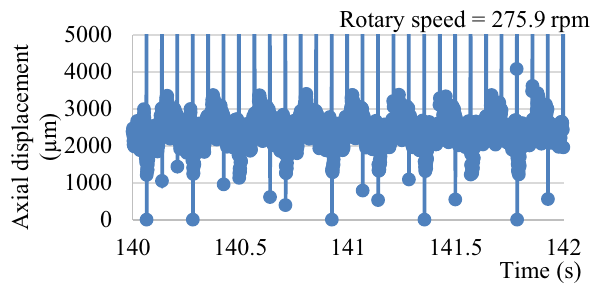
Fig. 19 Kick effects on rotary speed—no-kick region #1 for Run_1